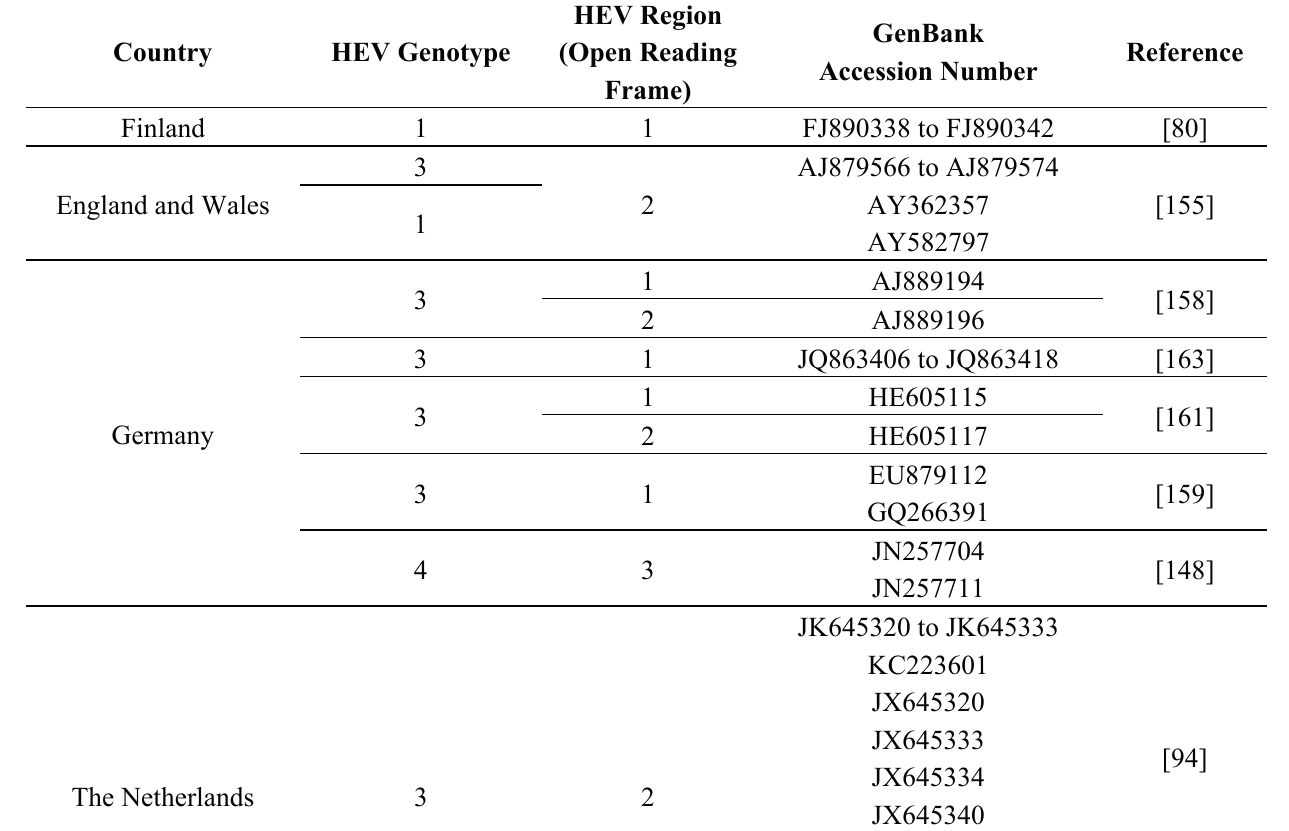
Table 3. Some representative Human HEV sequences described in European countries.